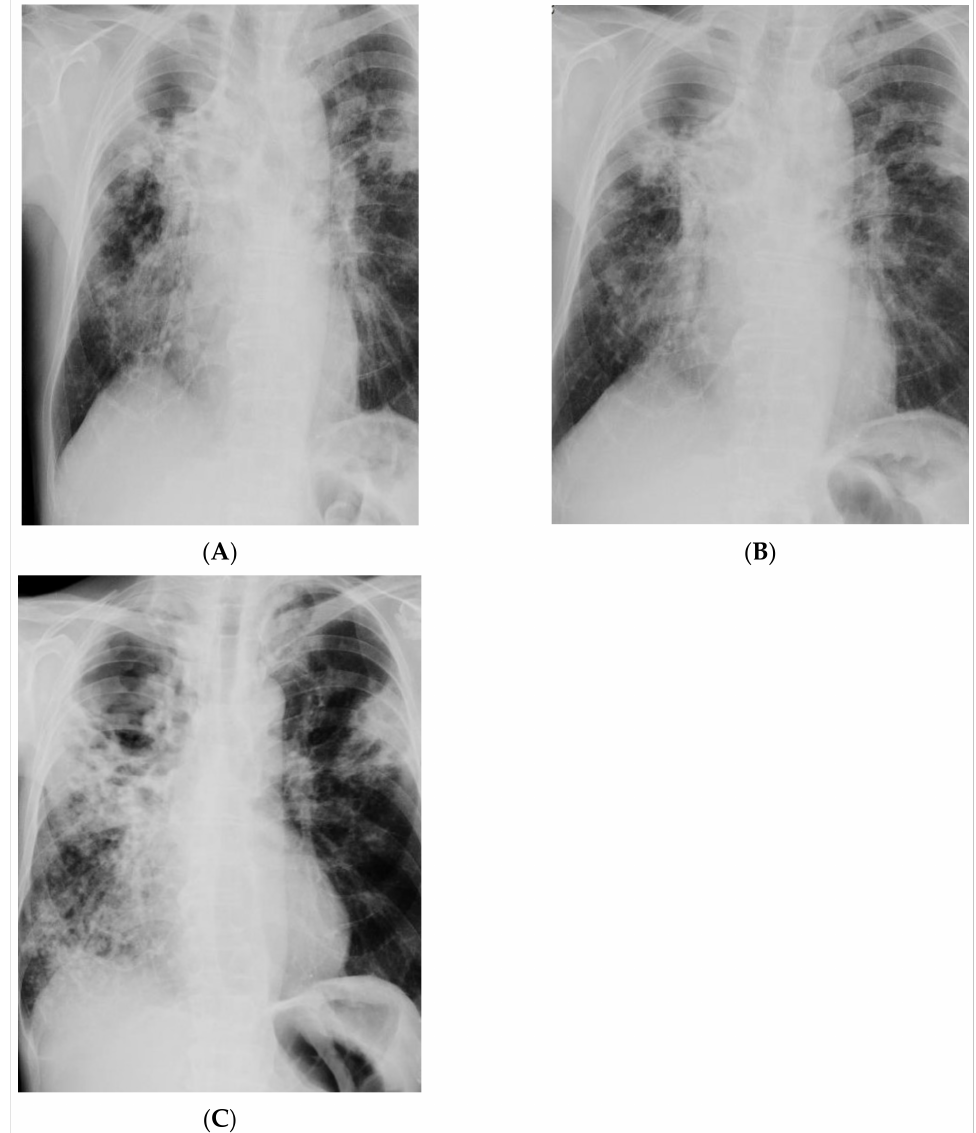
Figure 5. ( A )—X-ray of the chest taken on admission to hospital. Chest X-ray showed extensive bilateral infiltrative lesions and a large thick-walled cavity in the upper right area (size 114 × 83 mm); ( B )—X-ray taken after 17 months of treatment, no radiological improvement; ( C )—X-ray taken in April 2022, no radiological improvement after 2 years of treatment. There are diffuse, blotchy, confluent dense areas in the parenchyma covering the upper and middle areas of the right lung and the middle area of the left lung. Some fibrous component of lesions distorting the shape of the hila. A cavity, 83 mm in diameter, present in the apical area of the right lung. A cavity, 24 mm in diameter, in the middle area of the left